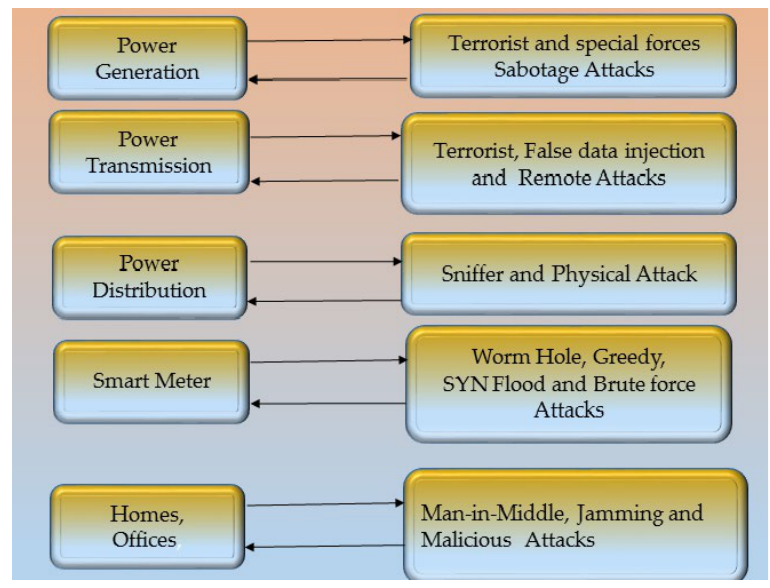
Figure 7. The possible attacks on the smart grid [102].